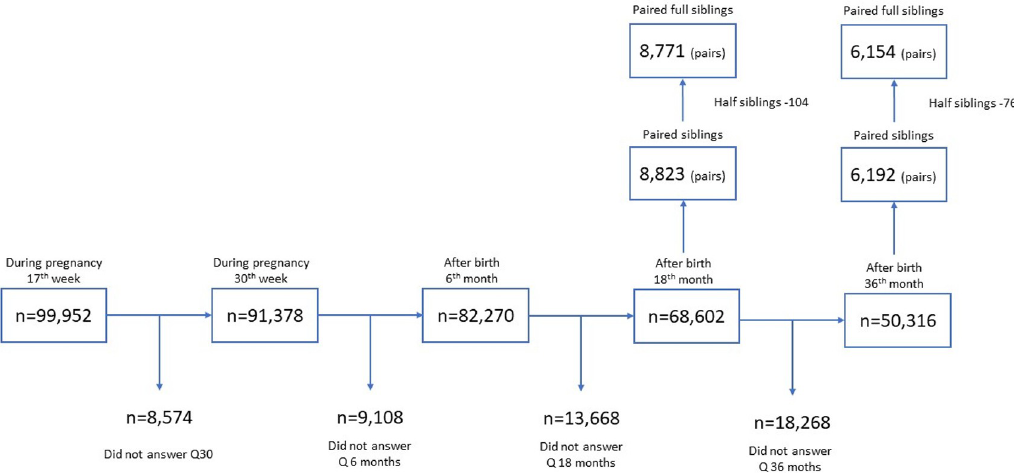
Fig 1. Flow chart of study sample. Note: The half siblings refer to the siblings with the same mother but different fathers.